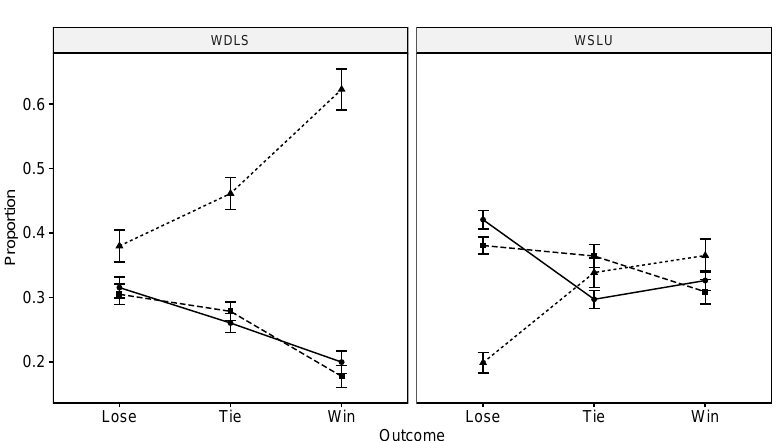
Figure 9. The proportion of each strategy following different outcomes in the WDLS and WSLU conditions. Error bar represents one standard